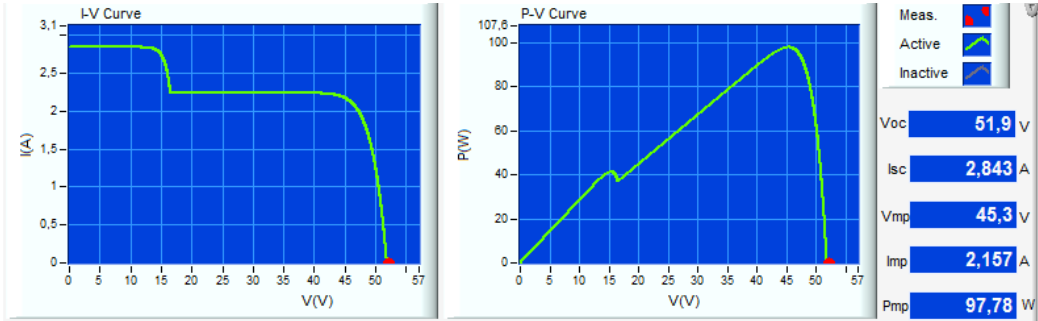
Figure 17. I-V and P-V curve generated by a PV simulator for the second PSC (300 – 400 – 400 W/m 2 ).